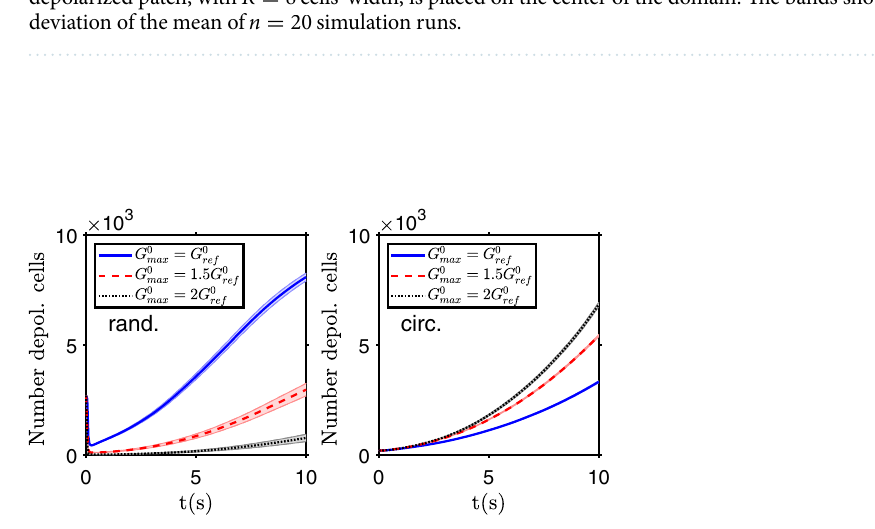
Figure 7. Community effect. Evolution of the number of depolarized cells for different values of the gap junction conductivity parameter G 0 max . The depolarization starts from a random distribution of depolarized cells, 27% of the total (left), or from a circle of depolarized cells, with R = 8 cells’ width, at the center of the two dimensional domain (right). The bands show the standard deviation of the mean of n = 50 simulation